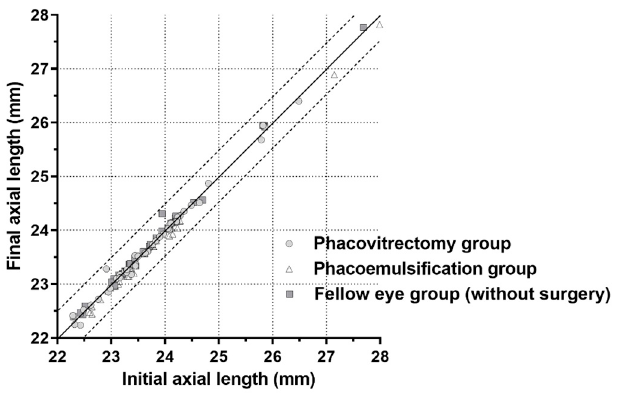
Figure 1. Scatterplot showing the initial and final axial lengths in all groups. The circles, triangles, and squares between the two lines show axial lengths that changed ≤ 0.5 mm within 2 years.